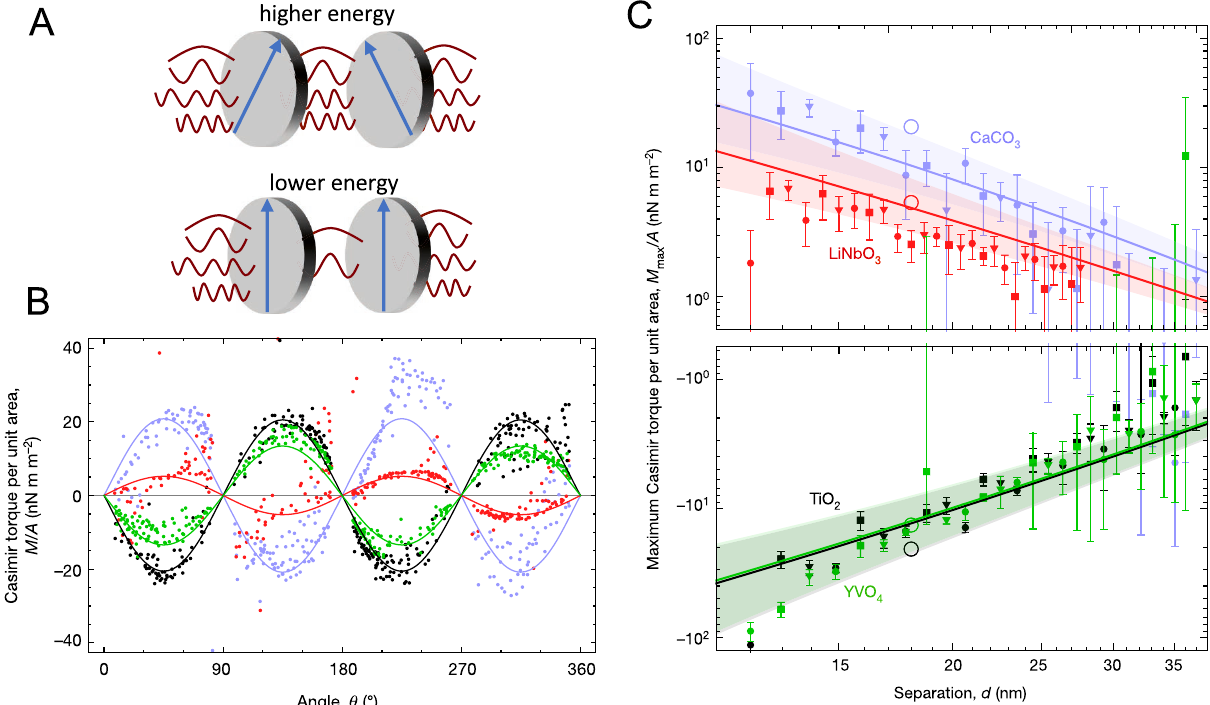
Figure3: Casimirtorque.(A)Whenmaterialswithopticalanisotropyareusedinsteadofisotropicmetalplates,theenergyassociatedwiththe quantum fluctuations depends on their orientation and results in a torque. This Casimir torque is found to (B) have a sin(2 θ ) dependence and (C) decrease in magnitude with increasing separation between the plates. (B and C) Adapted with permission from the study by Somers et